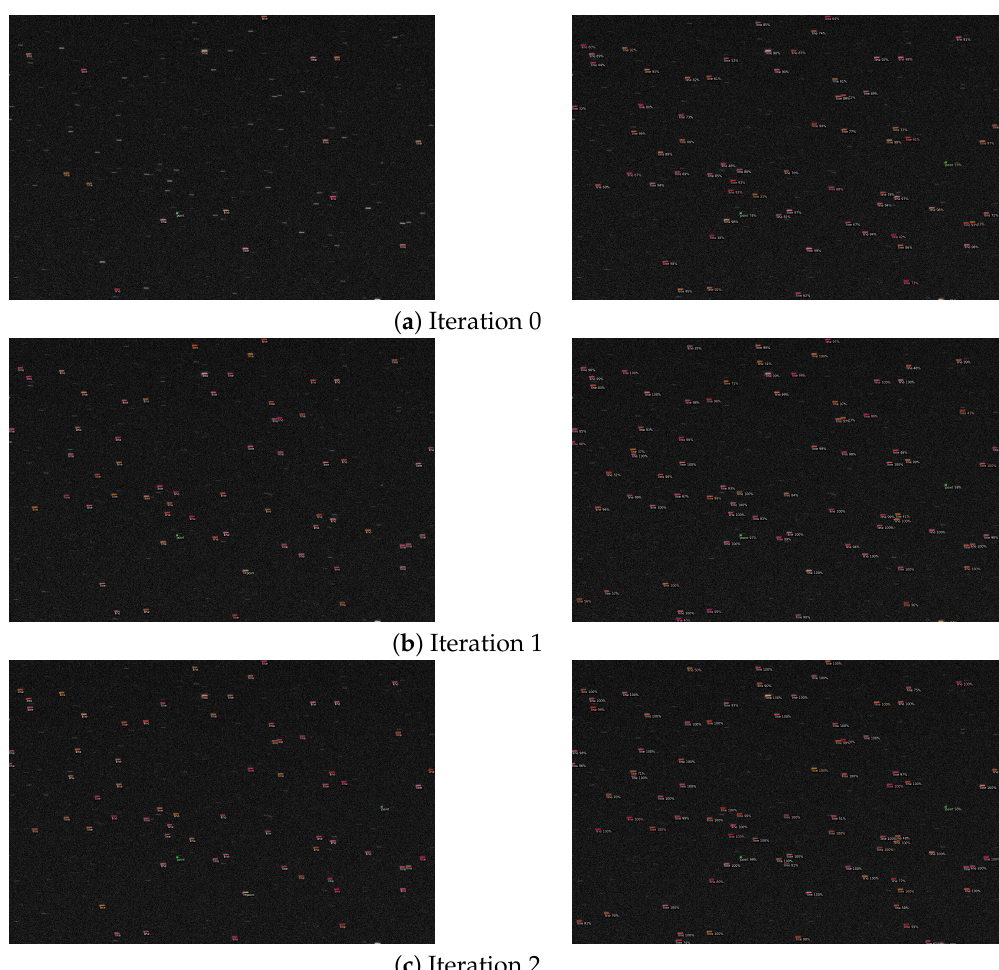
Figure A1. Comparison between the annotated objects (left) and the detector results (right) at different steps of the re-annotation